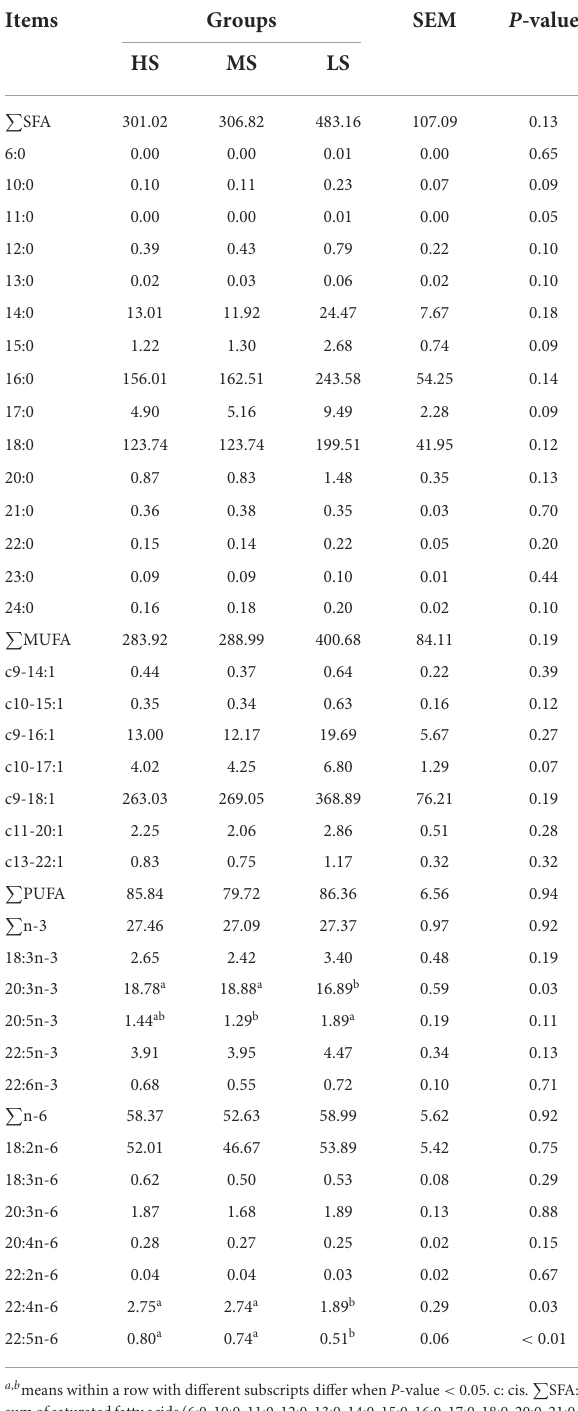
TABLE 6 Effect of different energy level diets on the fatty acid composition in the longissimus lumborum of Tibetan sheep (mg/100g